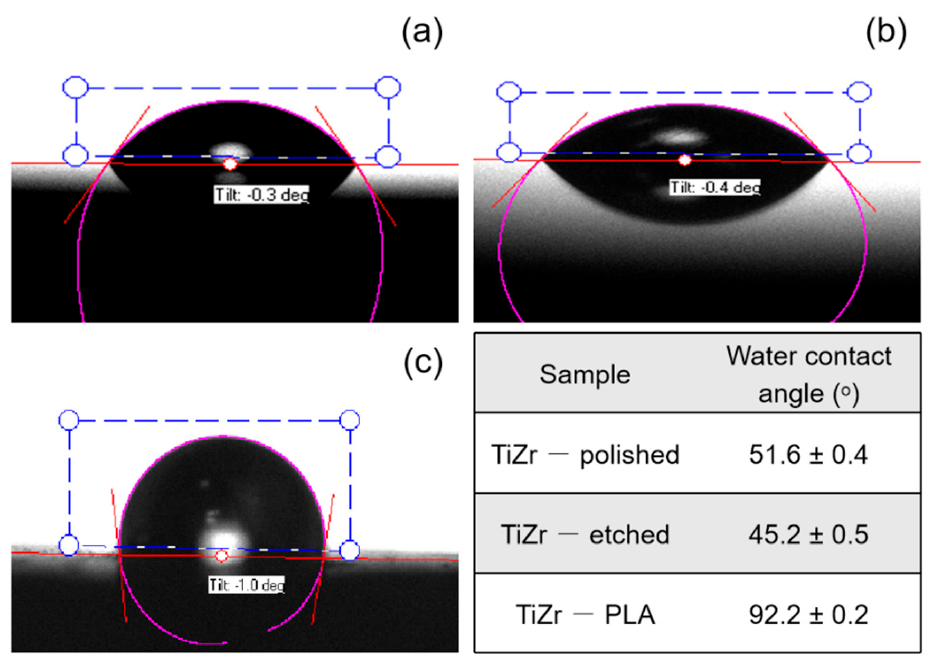
Figure 2. Contact angle measurements for ( a ) polished TiZr; ( b ) etched TiZr; ( c ) etched TiZr covered with PLA nanofibers. Measured contact angle values.